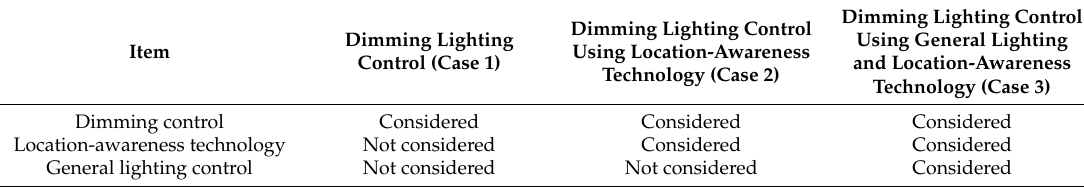
Table 8. Case setting for performance